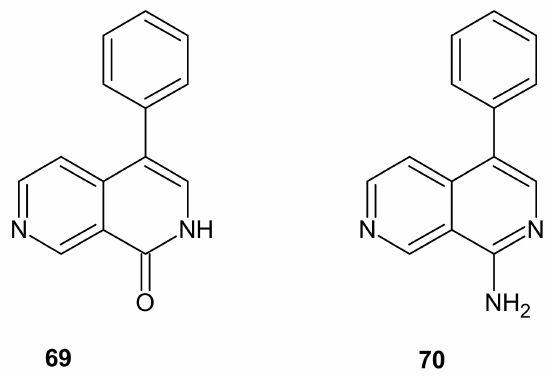
Figure 23. Structure of lophocladines 69 – 70